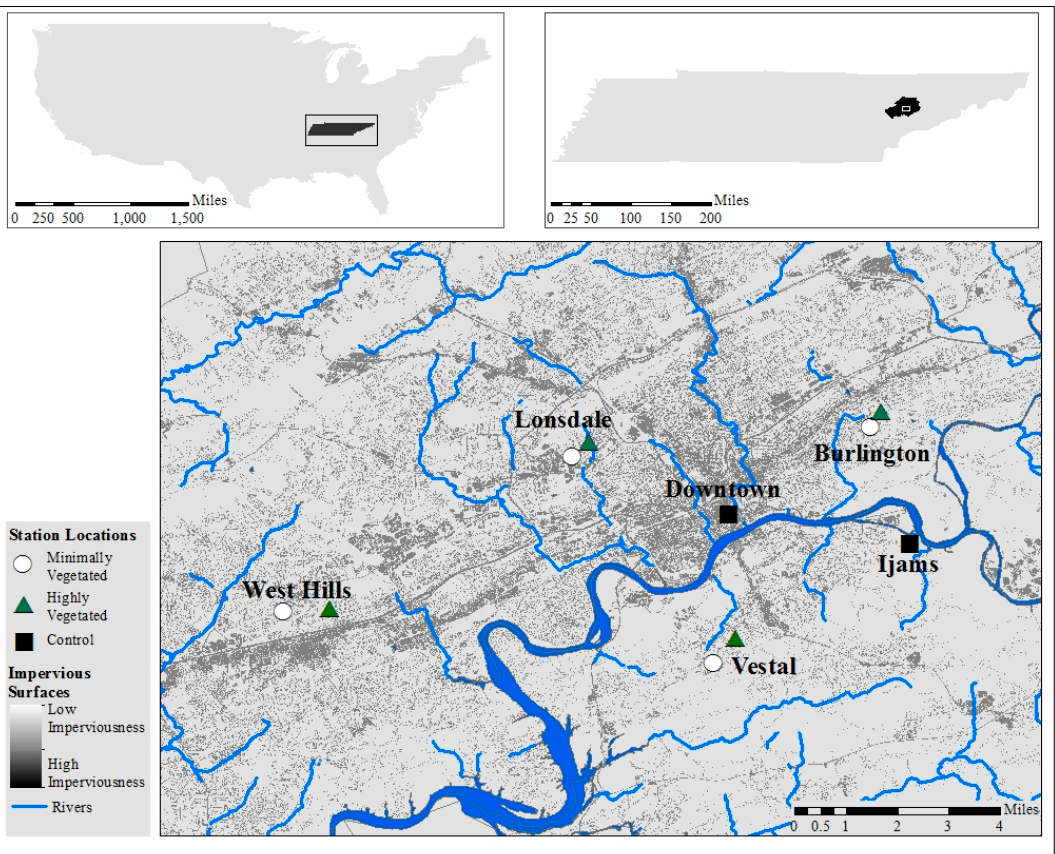
Figure 1. Locations of minimally vegetated (MV) and highly vegetated (HV) weather stations within each neighborhood, and control weather stations downtown and in Ijams Nature Center, and amount of imperviousness in the City of Knoxville.